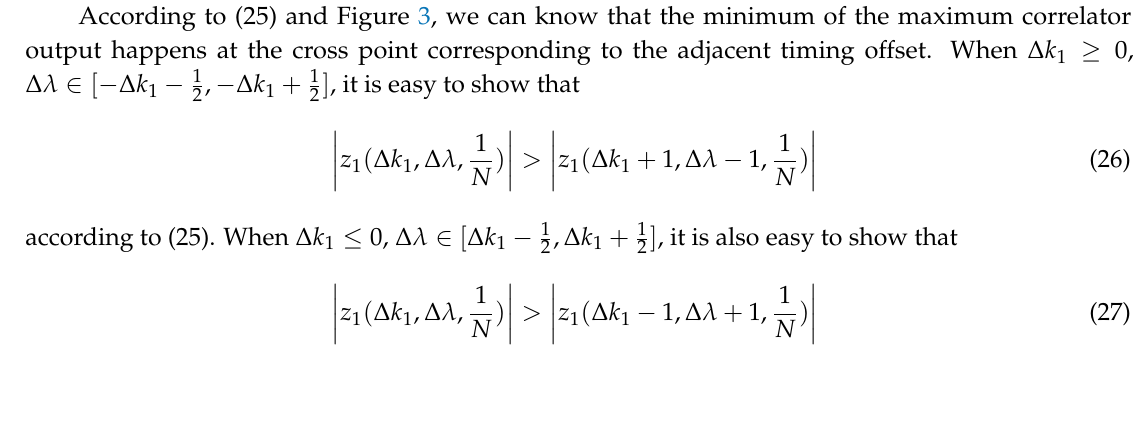
Figure 3. Illustration of the correlator output of the ZC sequence with root µ = 1 under different timing offsets.